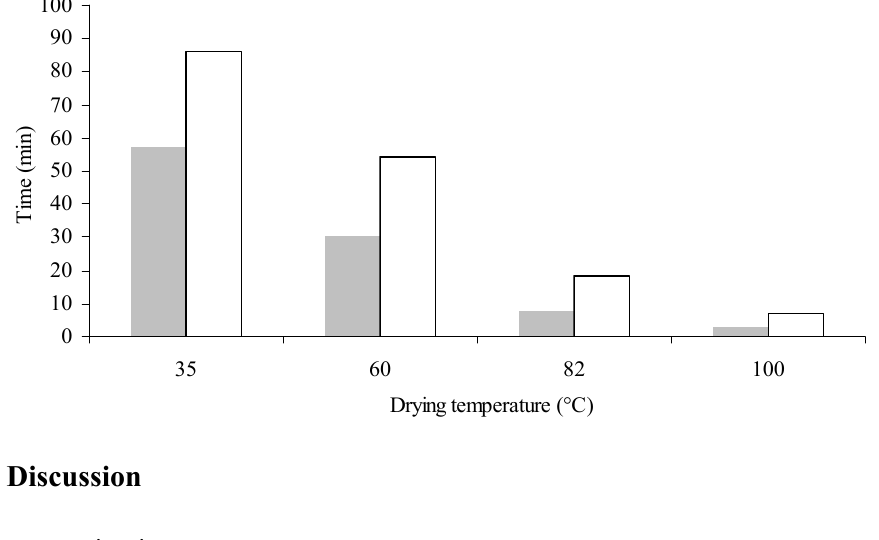
Figure 1. Drying times of canola samples at an initial moisture level of 13.6% db ( ■ ) and 22.7% db ( □ ) and final moisture content of 7% db. Eight independent drying experiments. n (number of replicates of each measurement): 2.